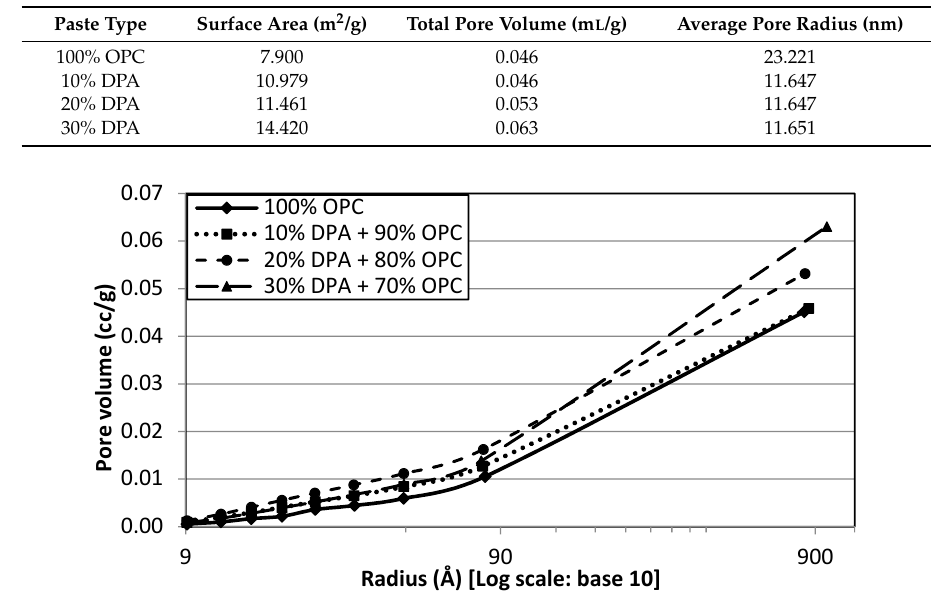
Figure 9. Surface area distribution in all mixtures. Table 4. Total pore volume, surface area, and average pore radius of paste mixtures at 28 days. Paste Type